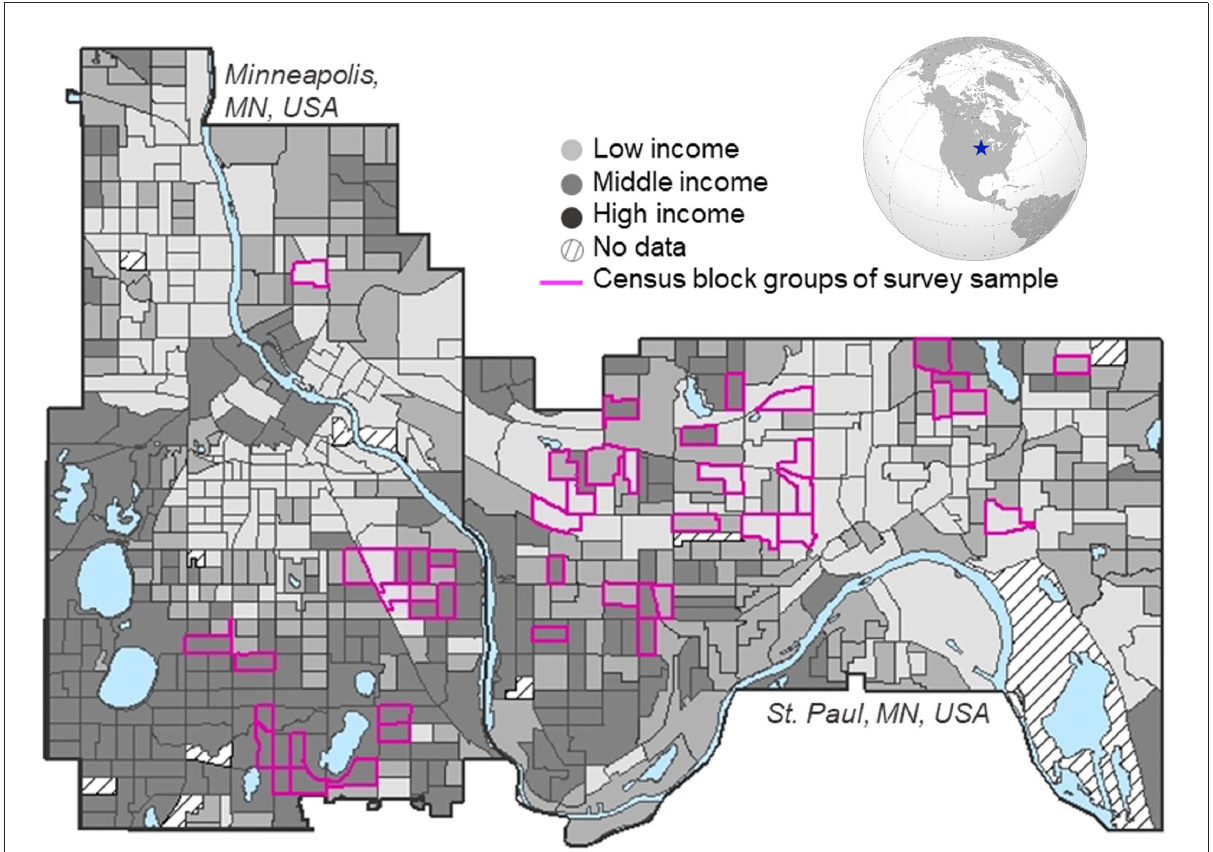
FIGURE1 Map of Minneapolis (left) and St. Paul (right) , together referred to as the Twin Cities, showing the distribution of high—(dark gray), middle—(medium gray), and low—(light gray) income by household. The pink outlines illustrate the census block groups included in the ground survey. Geographic location of the Twin Cities in reference to North America starred in the top right of the